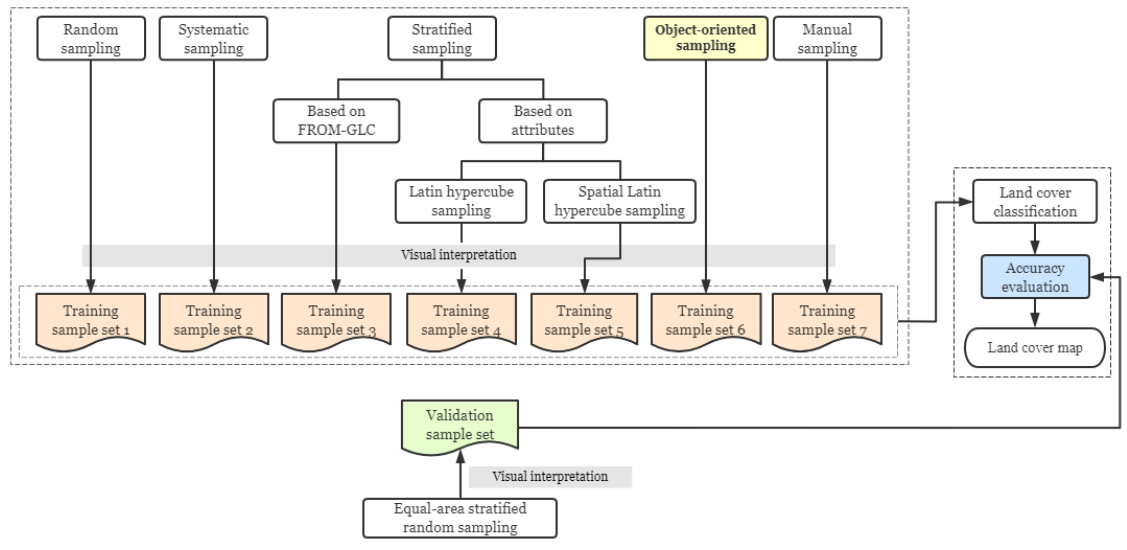
Figure 2. Workflow of this study.